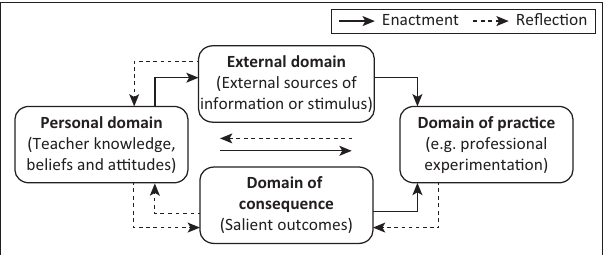
FIGURE 1: Model of teacher change.